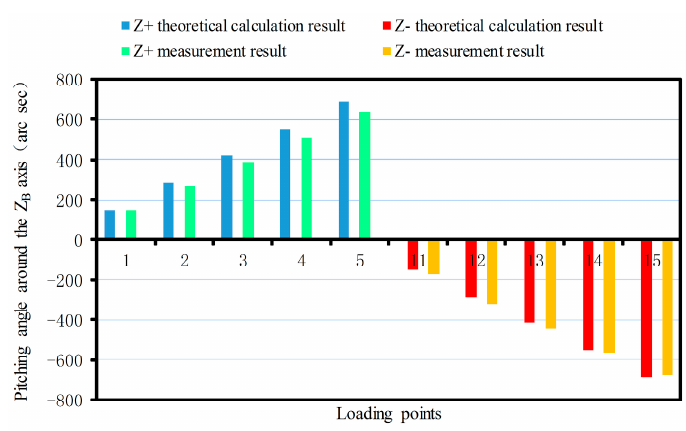
Figure 17. Pitching angle comparison around the Z B